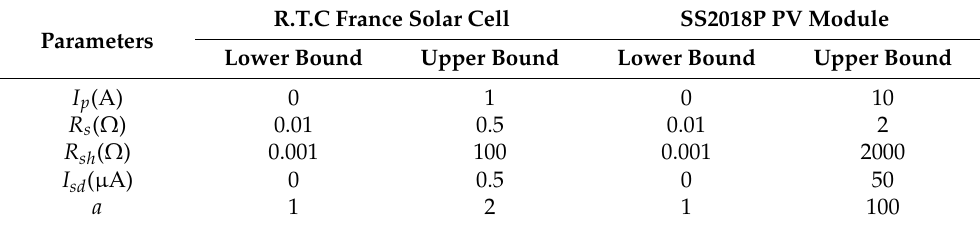
Table 1. The parameter range for SDM of a solar cell and a PV module.